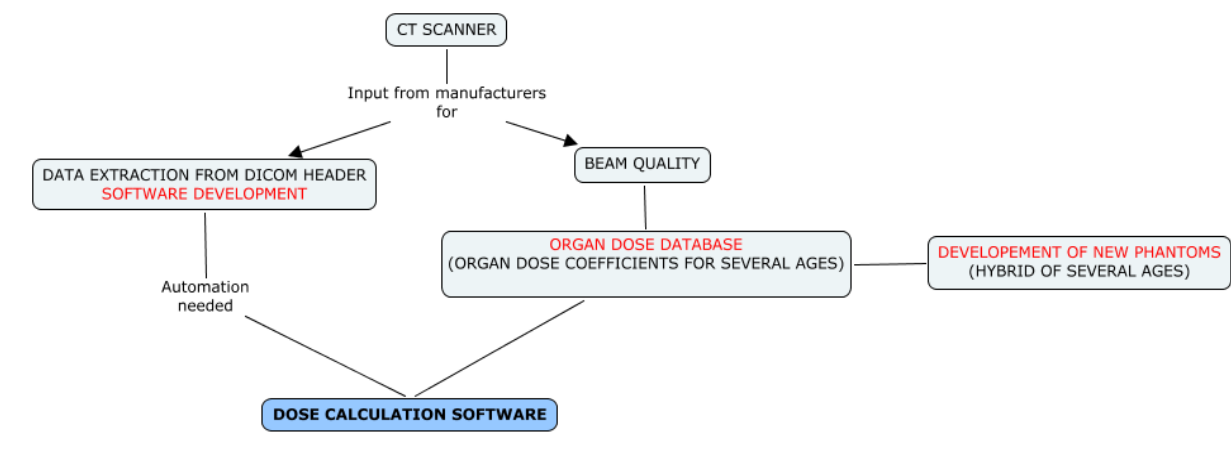
Figure 3. Dose reconstruction strategy in Scenario